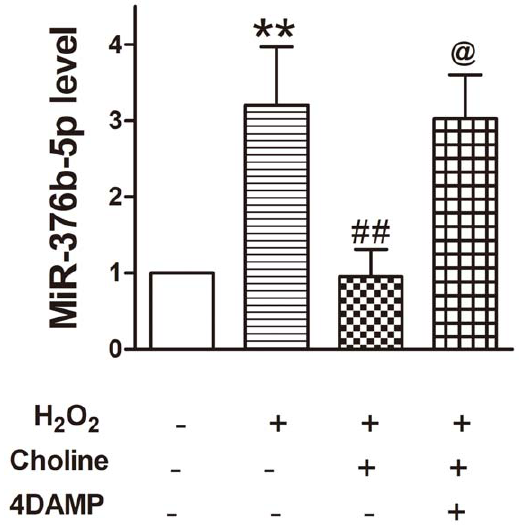
Figure 3. M 3 -mAChR inhibits the up-regulation of miR-376b-5p stimulated by H 2 O 2 in H9c2 cells. H9c2 cells were co-incubated with H 2 O 2 (50 m M), choline (1 mM) and 4DAMP (5 nM) for 12 h. MiR- 376b-5p expression was determined by qRT-PCR. U6 served as an internal control for the normalization. Values were expressed as mean 6 SEM; n=4; ** P , 0.01 vs. Control, ## P , 0.01 vs. H 2 O 2 + choline, @ P , 0.05 vs. H 2 O 2 + choline + 4DAMP.